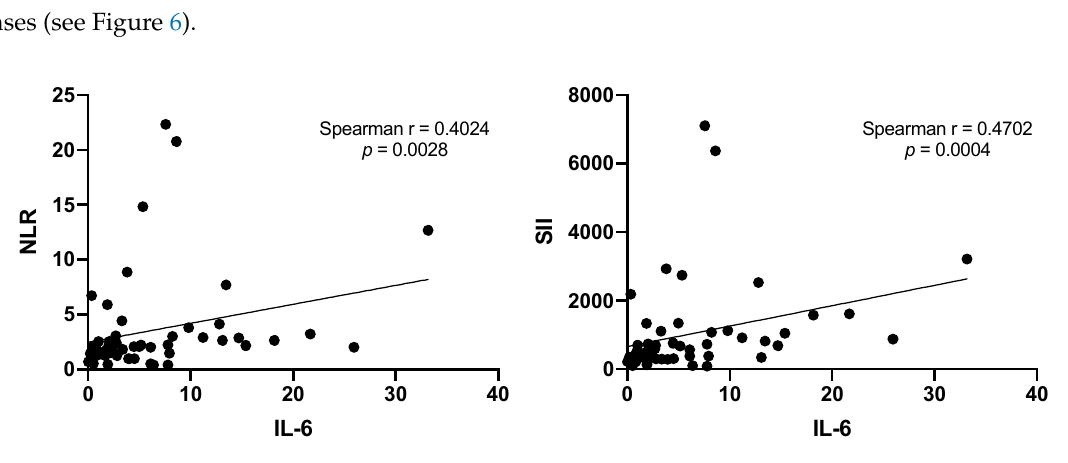
Figure 5. Neutrophil–lymphocyte ratio (NLR) and systemic immune-inflammation index (SII) values. Patients with shorter (<12 months, n = 22) and longer (>12 months, n = 31) OS. Median and interquartile ranges are shown.